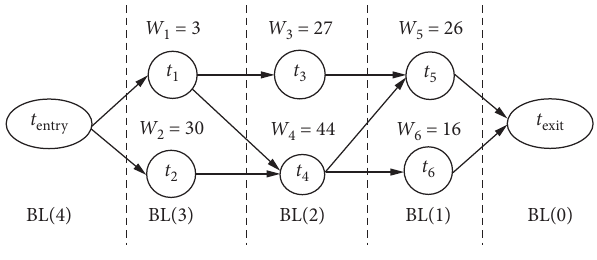
Figure 3: Layers of sample